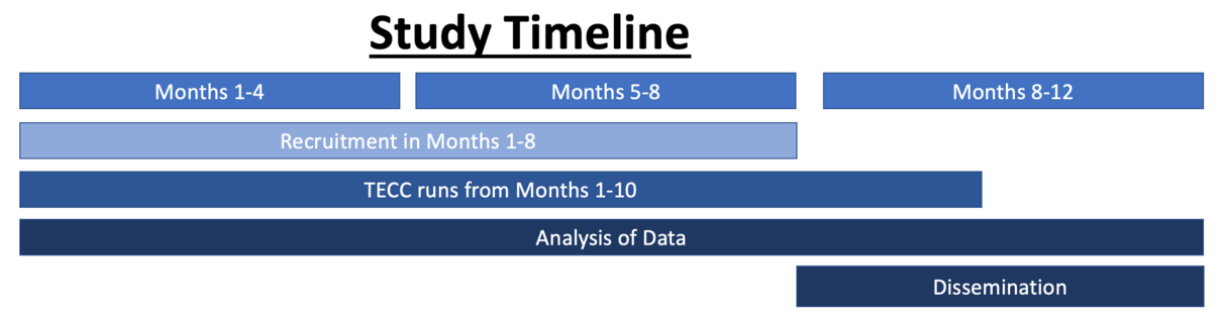
Figure 10. Study timeline. TECC: Technology Enabled Clinical